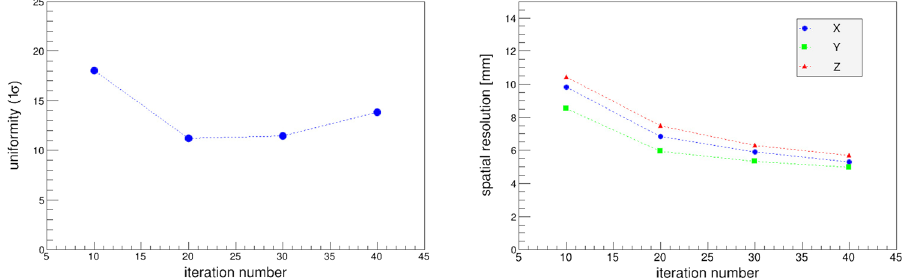
Figure 7. ( Left ) Uniformity (1 σ ) and ( right ) spatial resolution as a function of the number of iteration. The blue, green, and red plots in the right figure indicate the spatial resolution in the X, Y, and Z directions,